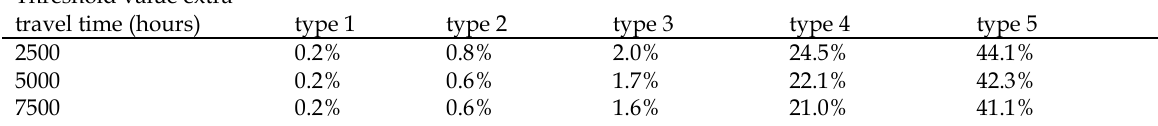
Table 3. Percentage of links of which the extra travel time that is caused by disturbances